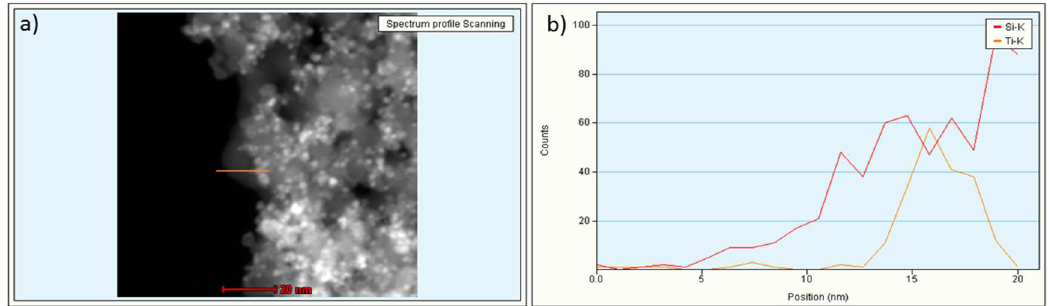
Figure 2. EDX-STEM analysis on the TiO 2 :SiO 2 1:1 sample: ( a ) sample area analyzed; ( b ) Si and Ti distribution within the selected area confirm the phase gradient represented in the sketch.